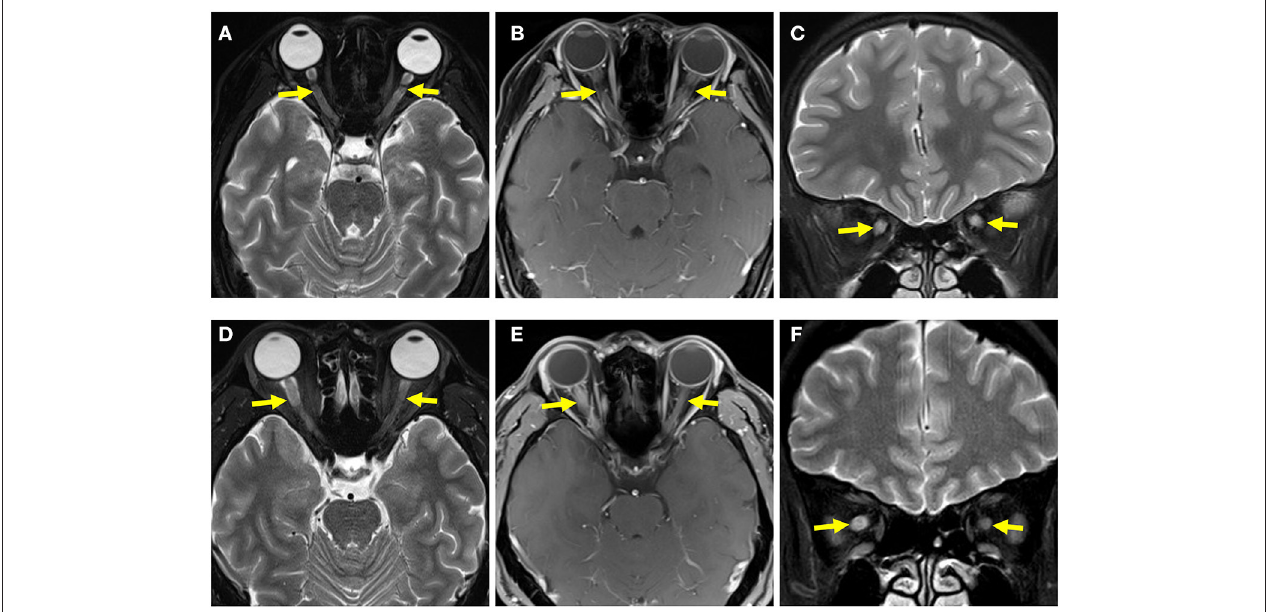
FIGURE 4 | Optic nerve MRI of pediatric and adult patients. (A) T2-weighted MRI of the optic nerve of a pediatric patient showed bilateral optic-nerve thickening. (B) T1-weighted gadolinium MRI of the optic nerve in a pediatric patient showed bilateral optic-nerve enhancement. (C) Coronal image showed bilateral optic-nerve thickening. (D) T2-weighted MRI of the optic nerve of an adult patient showed that the right optic nerve was thicker than the left optic nerve. (E) T1-weighted gadolinium MRI of the optic nerve of an adult patient showed right optic-nerve enhancement. (F) A coronal image showed that the right optic nerve was thicker than the left optic